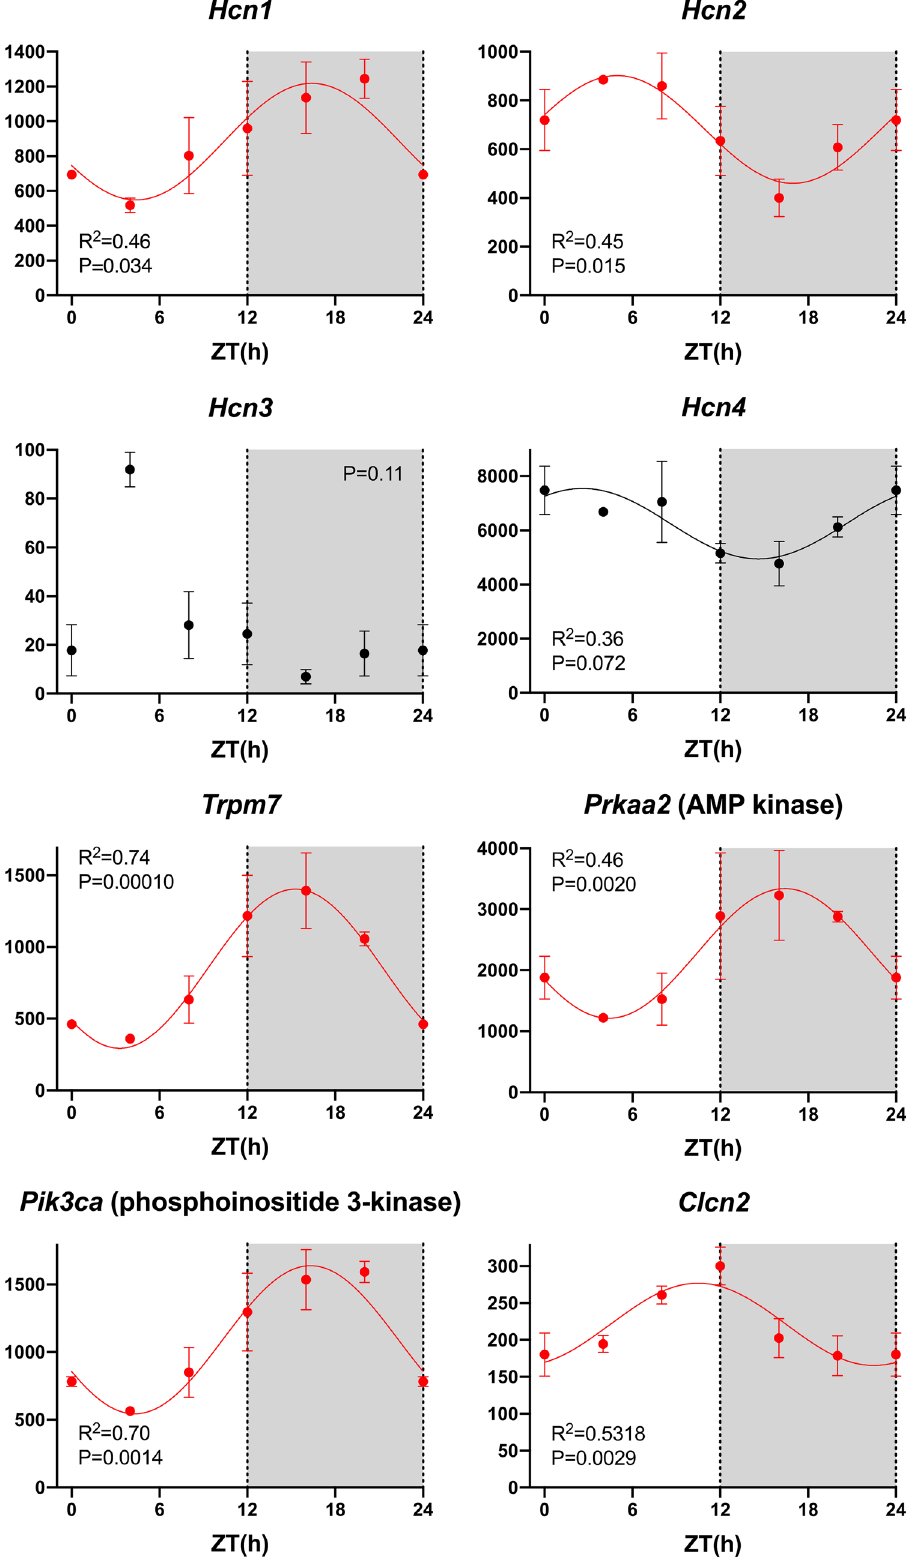
Figure 2. Membrane clock pacemaker mechanism. Abundance (normalised counts) of pacemaker ion channel transcripts and some potentially related transcripts is shown over 24 h. See Fig. 1 legend for further